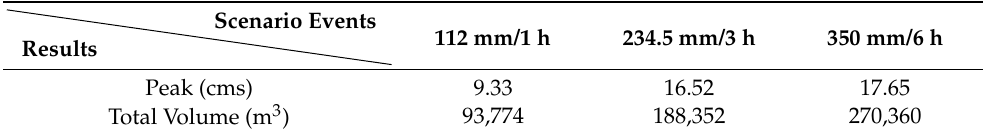
Table 6. Comparison of the hydrographical simulation results of different short-duration intense rainfall